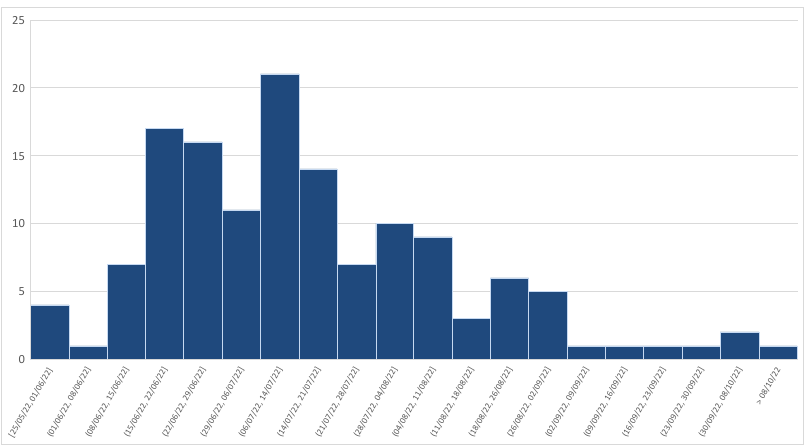
Figure 3. Weekly trend of mpox diagnoses from May to October 2022.